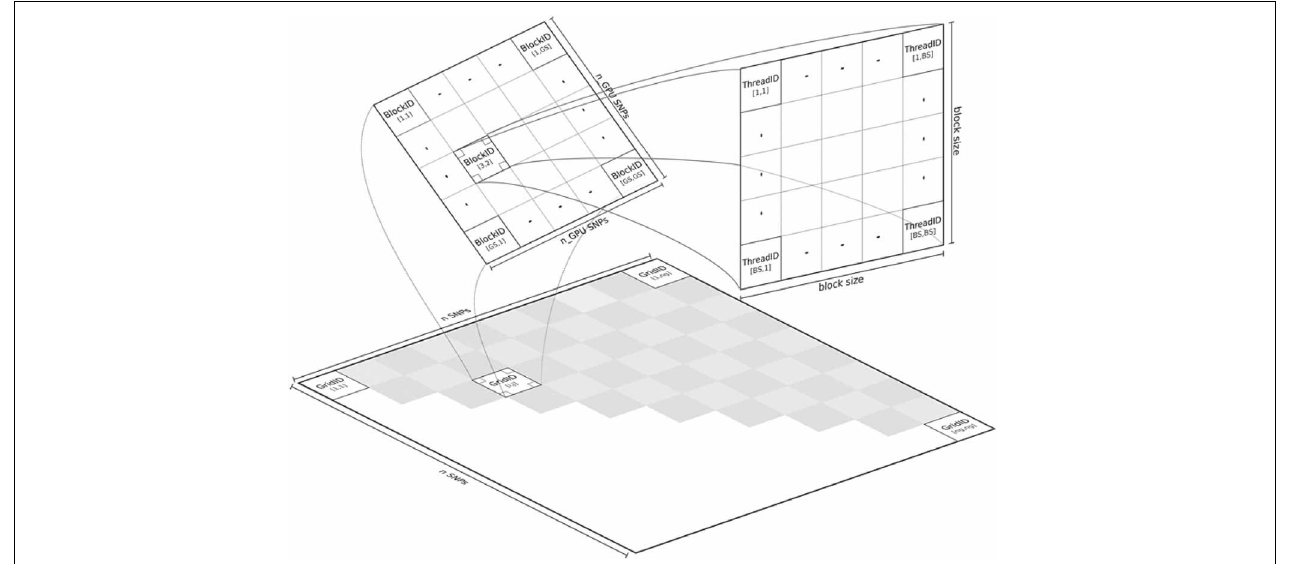
FIGURE 4 | Parallelization in GLIDE (figure from Kam-Thong et al.,